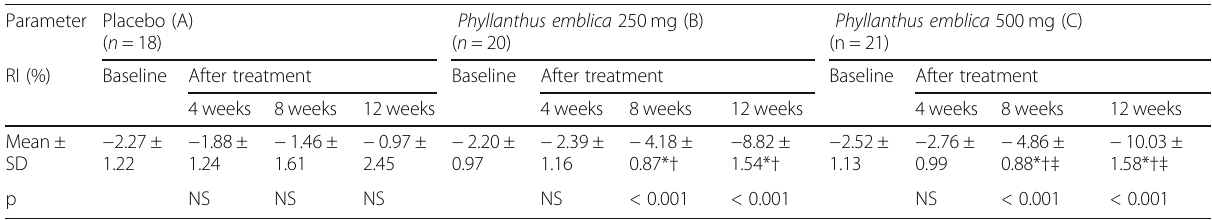
Table 2 Effect of Placebo, Phyllanthus emblica 250 mg and Phyllanthus emblica 500 mg on reflection index % (marker of endothelial